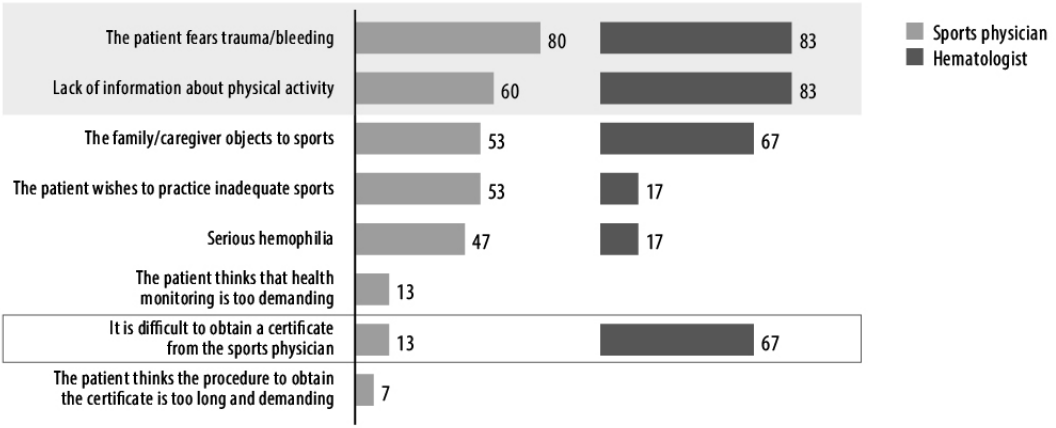
Figure 1. Barriers to the practice of sports by patients with hemophilia according to sports physicians and hematologists. Data are presented as percentage of responders, either sports physicians ( n = 15) or hematologists ( n = 6).